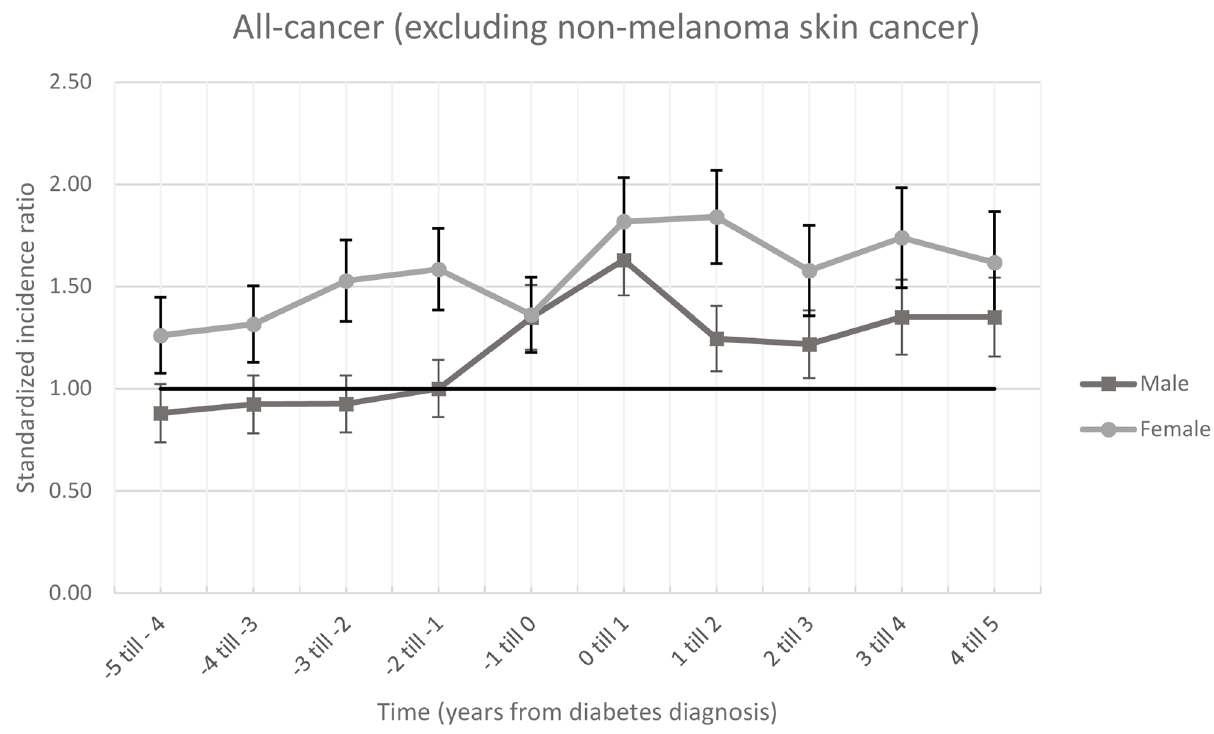
Fig 3. Standardized incidence ratio with 95%CI bars of all-cancer combined (excluding non-melanoma skin cancer). The horizontal line is 1.00 and means that the was no differences between the ZODIAC population and the general population.